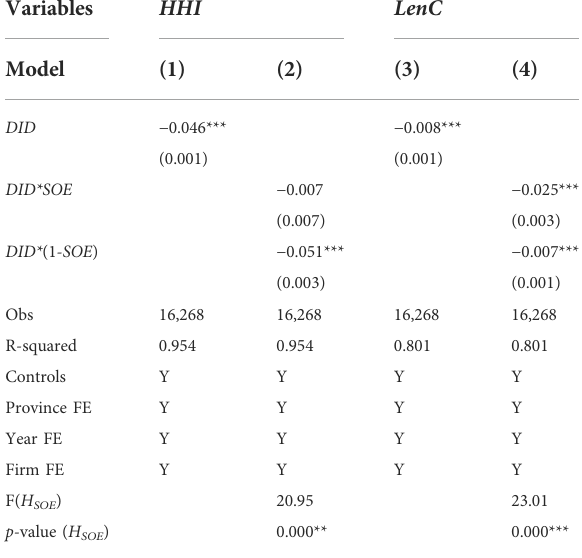
TABLE 15 Market competition mechanism estimation